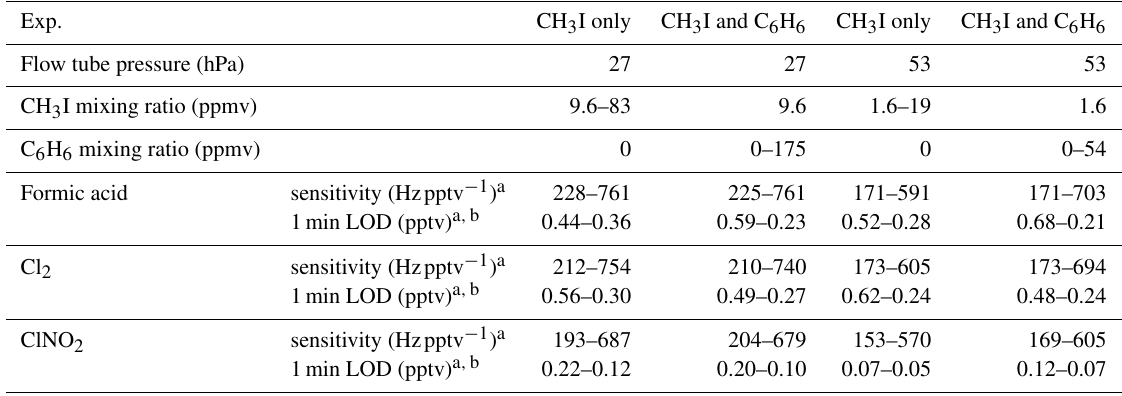
Table 2. Experiment conditions, sensitivities and limits of detection (LODs) for VUV-IS configuration (a).